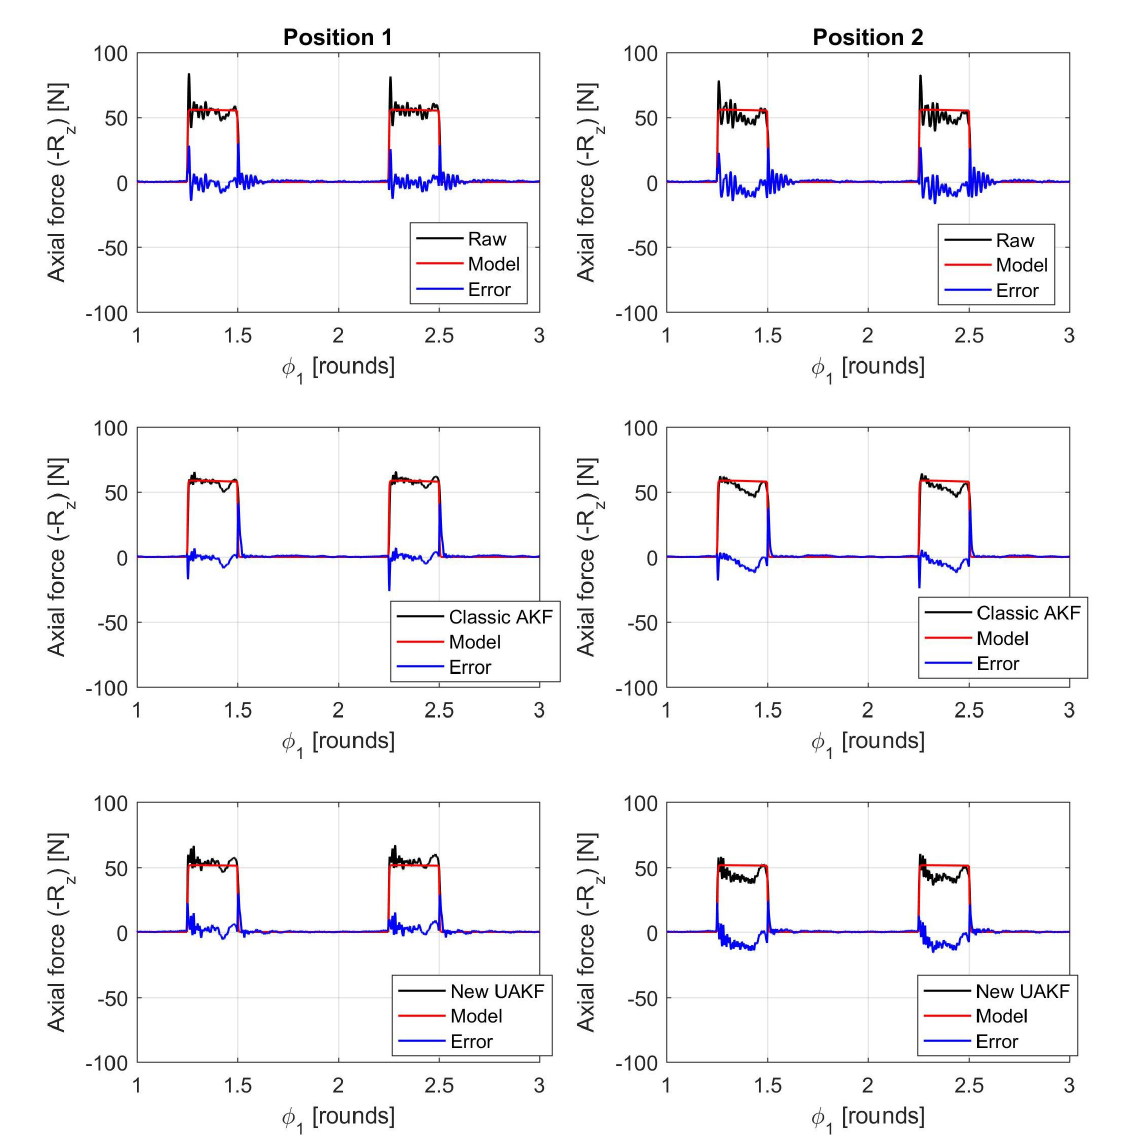
Figure 8. Comparison between filtered cutting forces and cutting force model along the axial direction Z ( a p = 0.8 mm, f z = 0.14 mm). The two subfigures in the middle show the filtered cutting forces obtained from the classical AKF that was based on both direct and cross TFRFs. The two subfigures on the bottom show the filtered cutting forces obtained from the novel UAKF approach. Moreover, all subfigures on the left refer to position 1 (milling bass beginning) while all subfigures on the right refer to position 2 (milling pass